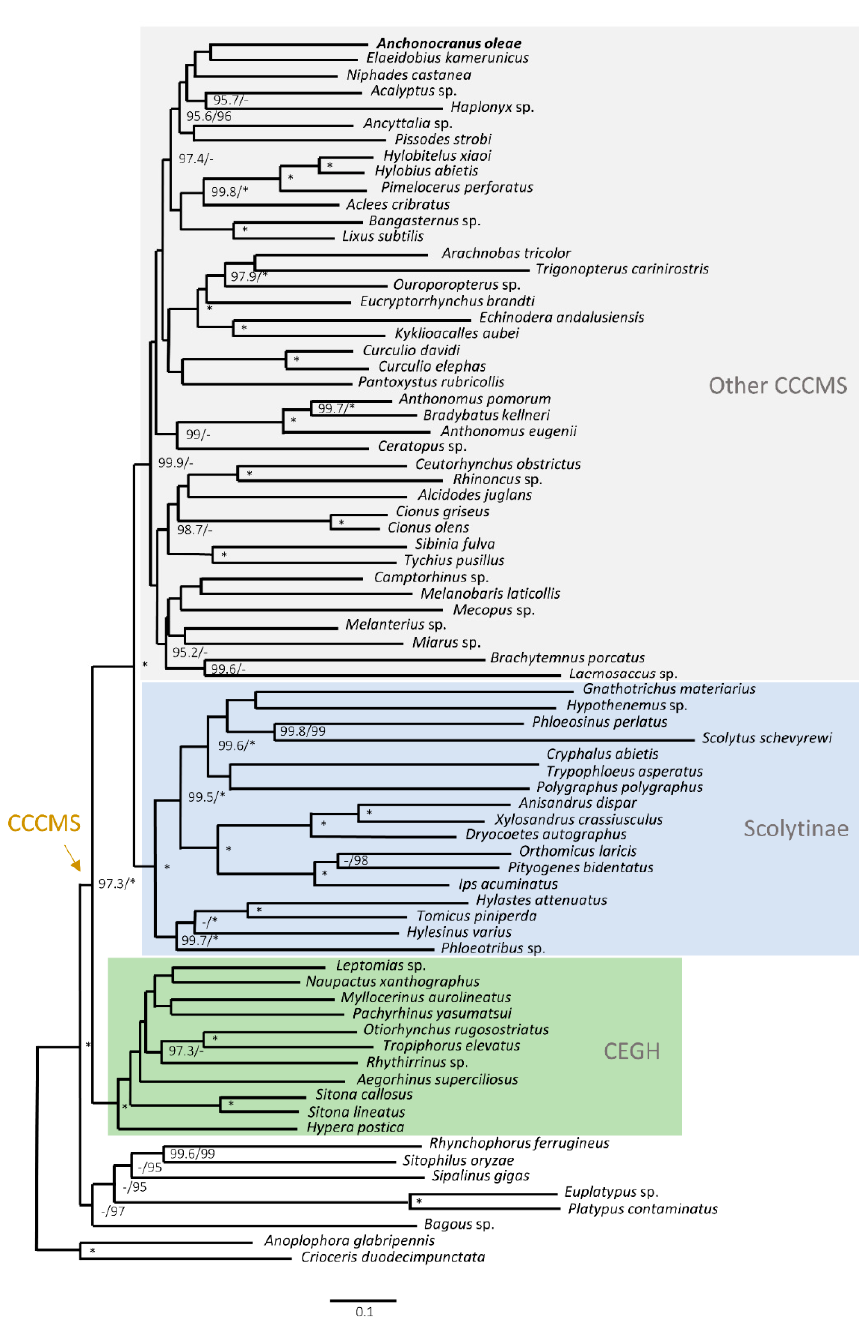
Table S2: Best-fit evolutionary